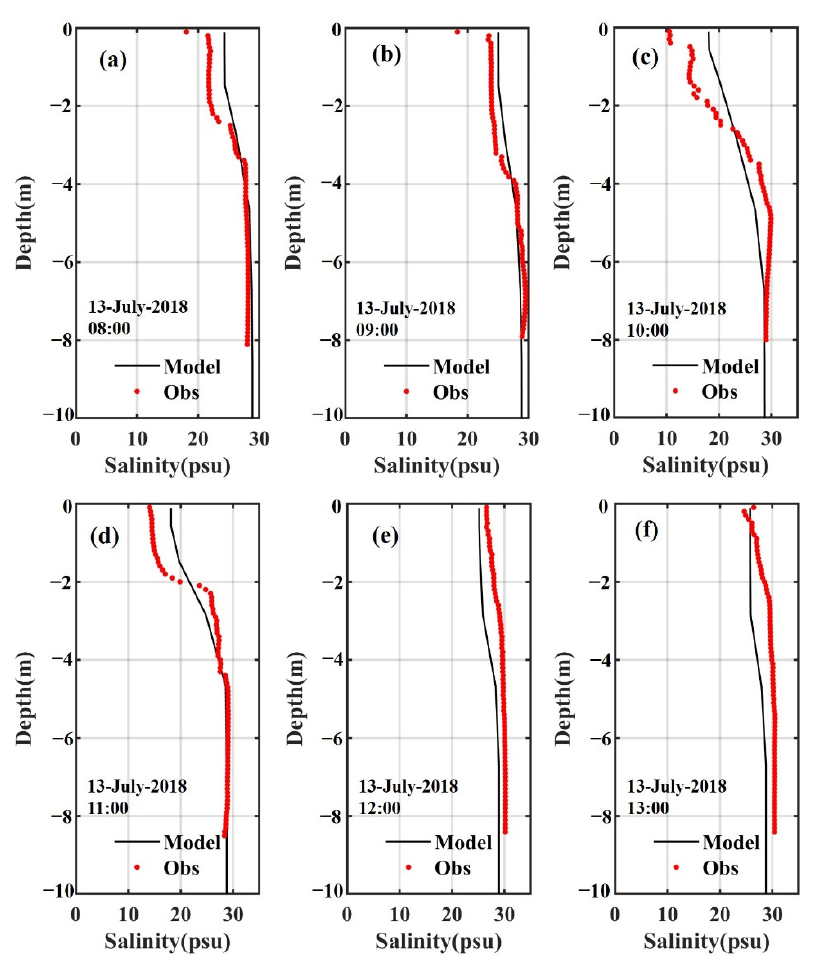
Figure 7. The comparison between computed and measured salinity. The time is in hours from 08:00 to 13:00 ( a – f ) on 13 July 2018.